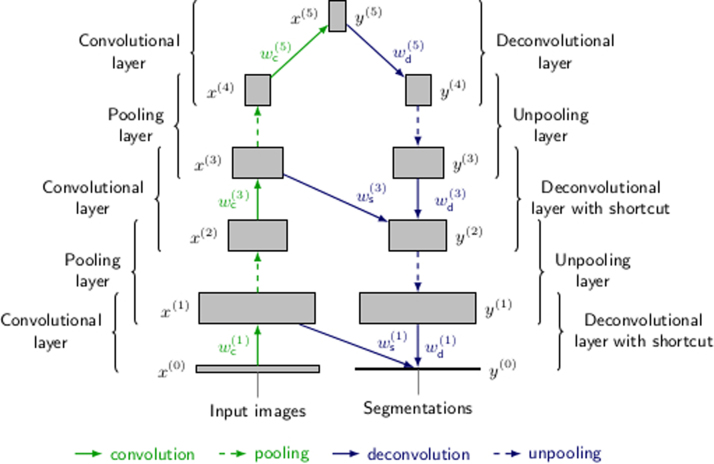
Diagram showing the 11-layer network structure used in the present work, based on the network presented by Brosch et al. (2016). The shortcut connections between corresponding convolutional and deconvolutional layers allow for the learning of features at different scales.